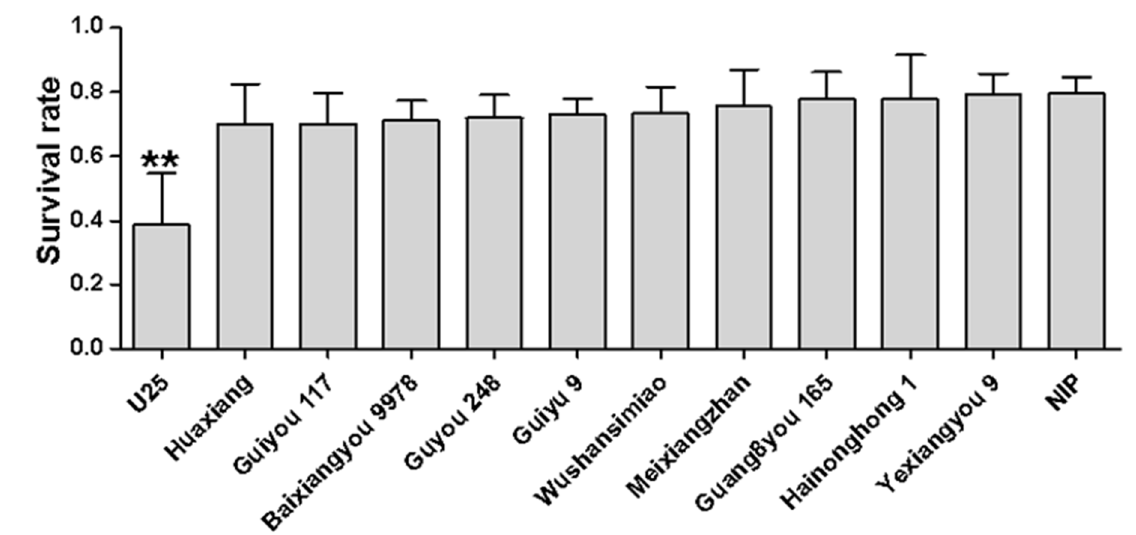
Figure 2. Determination of WBPHs survival rates on the seedlings of different rice varieties. Each variety was compared to NIP, “**” indicates an extremely significant difference ( p < 0.01).